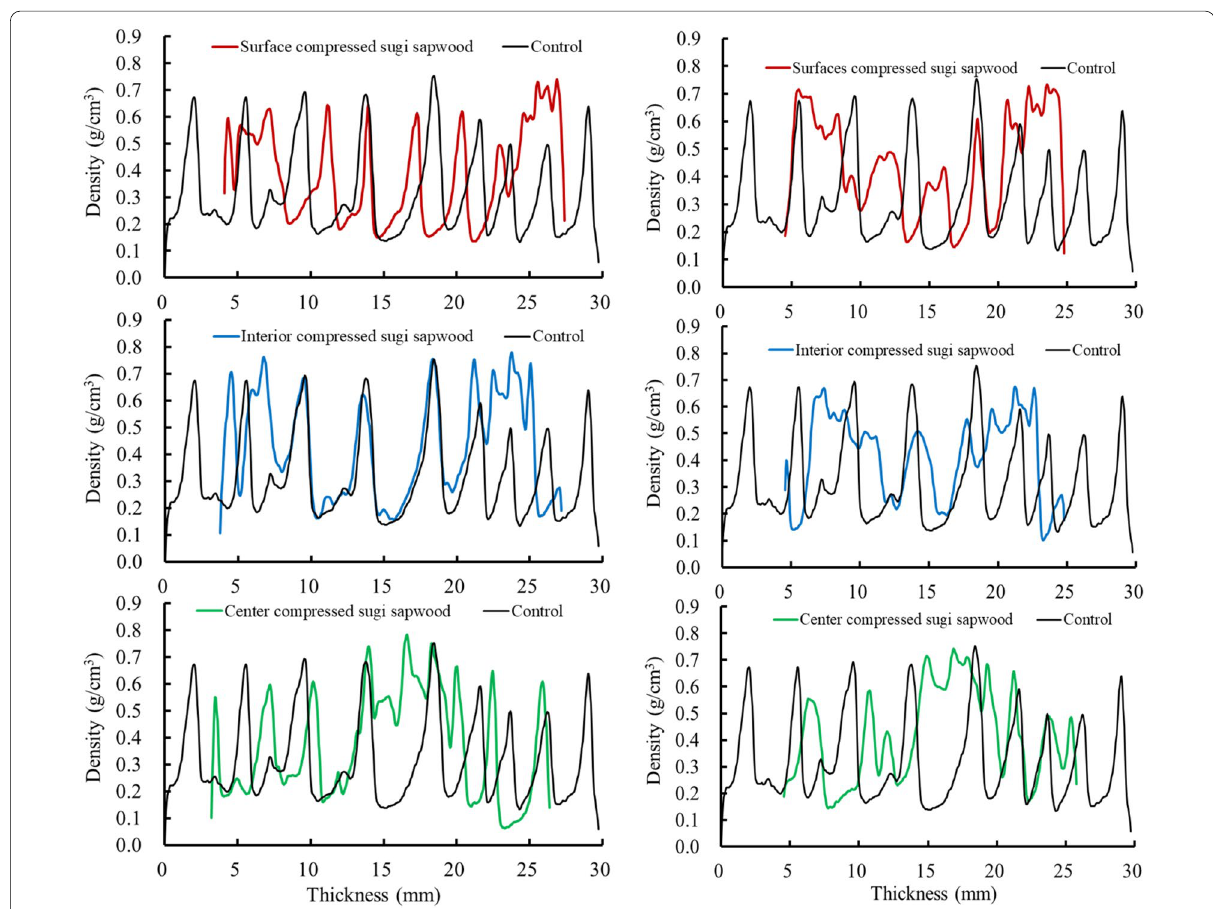
Fig. 4 Density distribution along the thickness of sandwich compressed sugi sapwood timber (left: compressed from 30 to 24 mm; right: compressed from 30 to 20